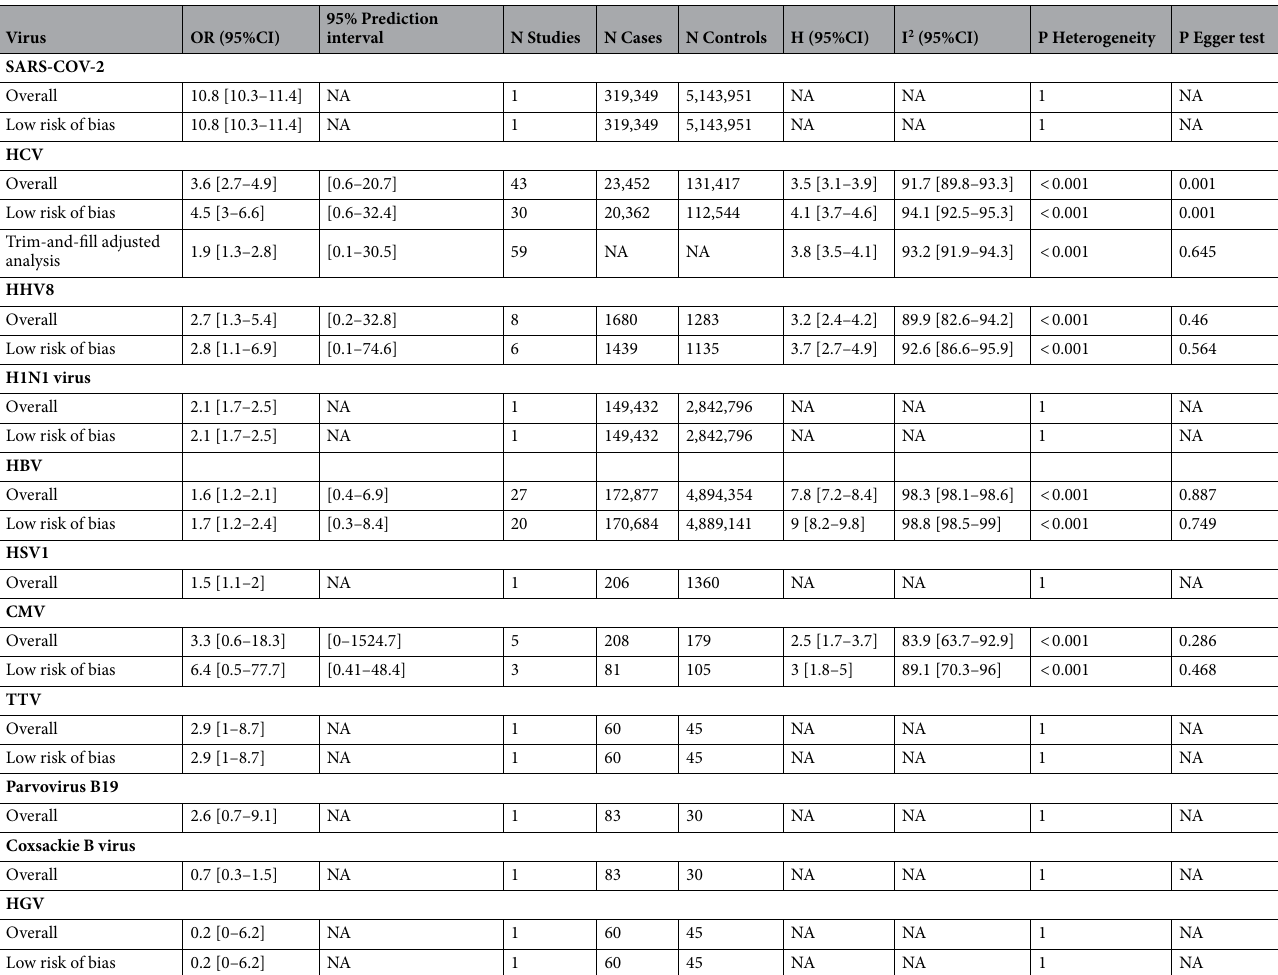
Table 2. Summary statistic of the association between non-autoimmune diabetes mellitus and type-specific virus. CMV Cytomegalovirus; SARS-CoV-2 Severe Acute Respiratory Syndrome Coronavirus 2; HBV Hepatitis B Virus; HCV Hepatitis C Virus; HGV Hepatitis G Virus; HHV8 Human Herpes Virus 8; HSV1 Herpes Simplex Virus 1; TTV Transfusion Transmitted